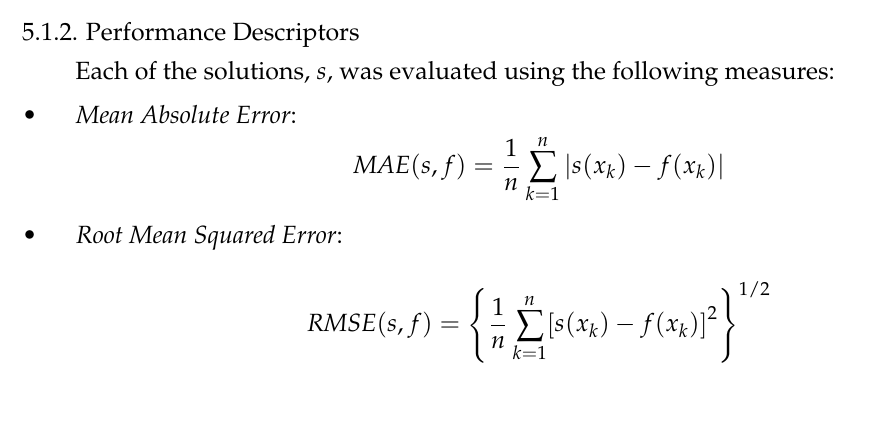
Figure 3. The test streams: ( a – d ) f 1 – f 4 (for readability shown only in the interval [ 0,500 ] ) generated from signal g using four levels of Gaussian noise (see Equation